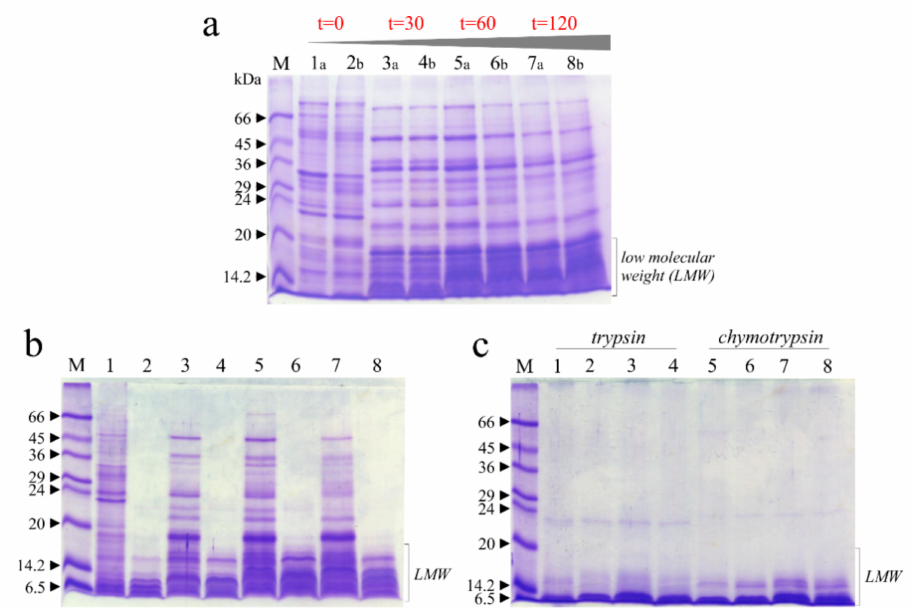
Figure 5. Raw soluble protein extracts from chickpea seeds subjected to in vitro protein digestibility with and without thermal treatment (boiling). ( a ), SDS-PAGE profiles of extracts collected in 2017 ( a ) and 2018 ( b ). Lanes 1 and 2, 3 and 4, 5 and 6, 7 and 8, extracts after thermal treatment (0, 30, 60 and 120 min, respectively). ( b ), SDS-PAGE profile of mixture extracts from seeds collected in 2017/2018 subjected to pepsin treatment. Lanes 1, 3, 5 and 7 boiled samples for 0, 30, 60 and 120 min without subsequent pepsin treatment. Lanes 2, 4, 6 and 8, boiled samples for 0, 30, 60 and 120 min with subsequent pepsin treatment (60 min). ( c ), SDS-PAGE profile of extracts subjected to trypsin or chymotrypsin treatment. Lanes 1, 2, 3, and 4, extracts after boiling (0, 30, 60 and 120 min; respectively), pepsin pretreatment (60 min) and subsequent trypsin treatment (60 min). Lanes 5, 6, 7 and 8, extracts after boiling (0, 30, 60 and 120 min; respectively), pepsin pretreatment (60 min) and subsequent chymotrypsin treatment (60 min). M, molecular weight markers. SDS-PAGE was